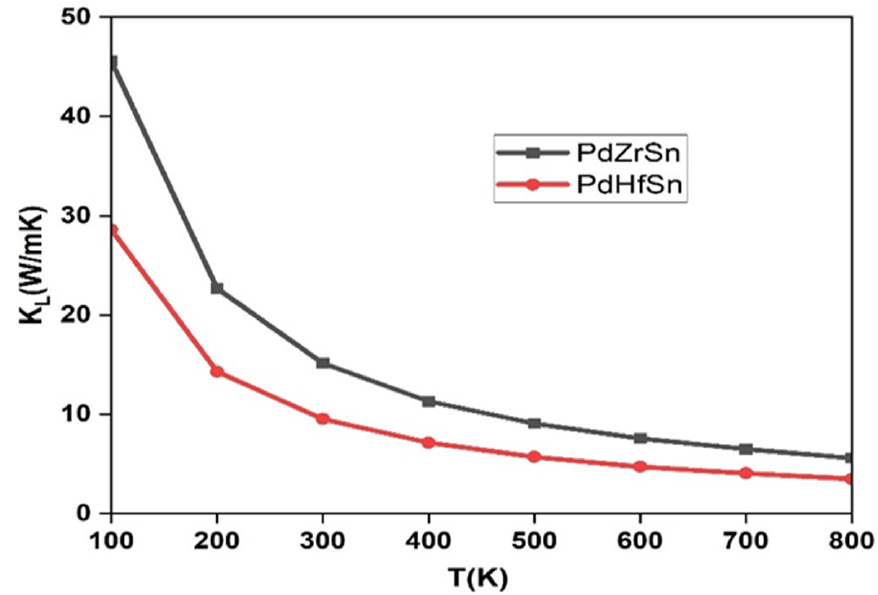
Figure 5. Variation of lattice thermal conductivity with temperature for PdZrSn and PdHfSn. Seebeck coefficient decreases as the carrier concentration increase with